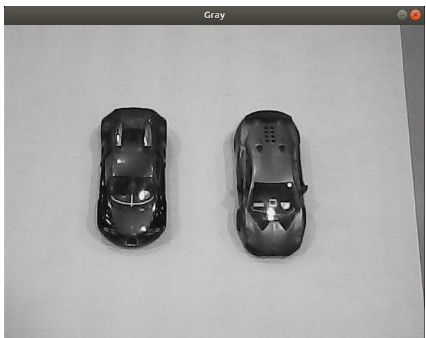
Figure 5. RGB to gray scale transformation The above image is the transformation of the captured image from RGB to gray scale.